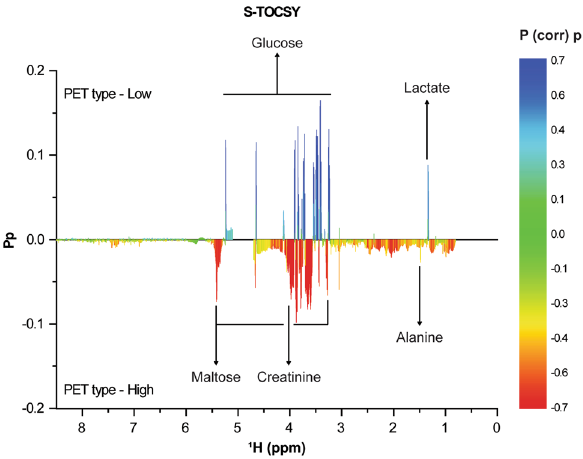
Figure 3. Identification of metabolites contributing to the discriminating model. S-TOCSY from the OPLS loading plot indicates the model coefficients for NMR variables. Signals are color-coded by the weights as a discriminator between the high and low PET types. Pp stands for modeled covariation, and P (corr) p stands for modeled correlation, as indicated by the color scale on the right. P (corr) p values for each of these signals indicate that multiple metabolite signals, rather than a single overwhelmingly prominent marker, contribute to differentiation. The metabolites that significantly distinguish the high and low PET types are annotated in the model coefficient plot. S-TOCSY statistical total correlation spectroscopy, OPLS orthogonal projections to latent structure, NMR nuclear magnetic resonance, PET peritoneal equilibration